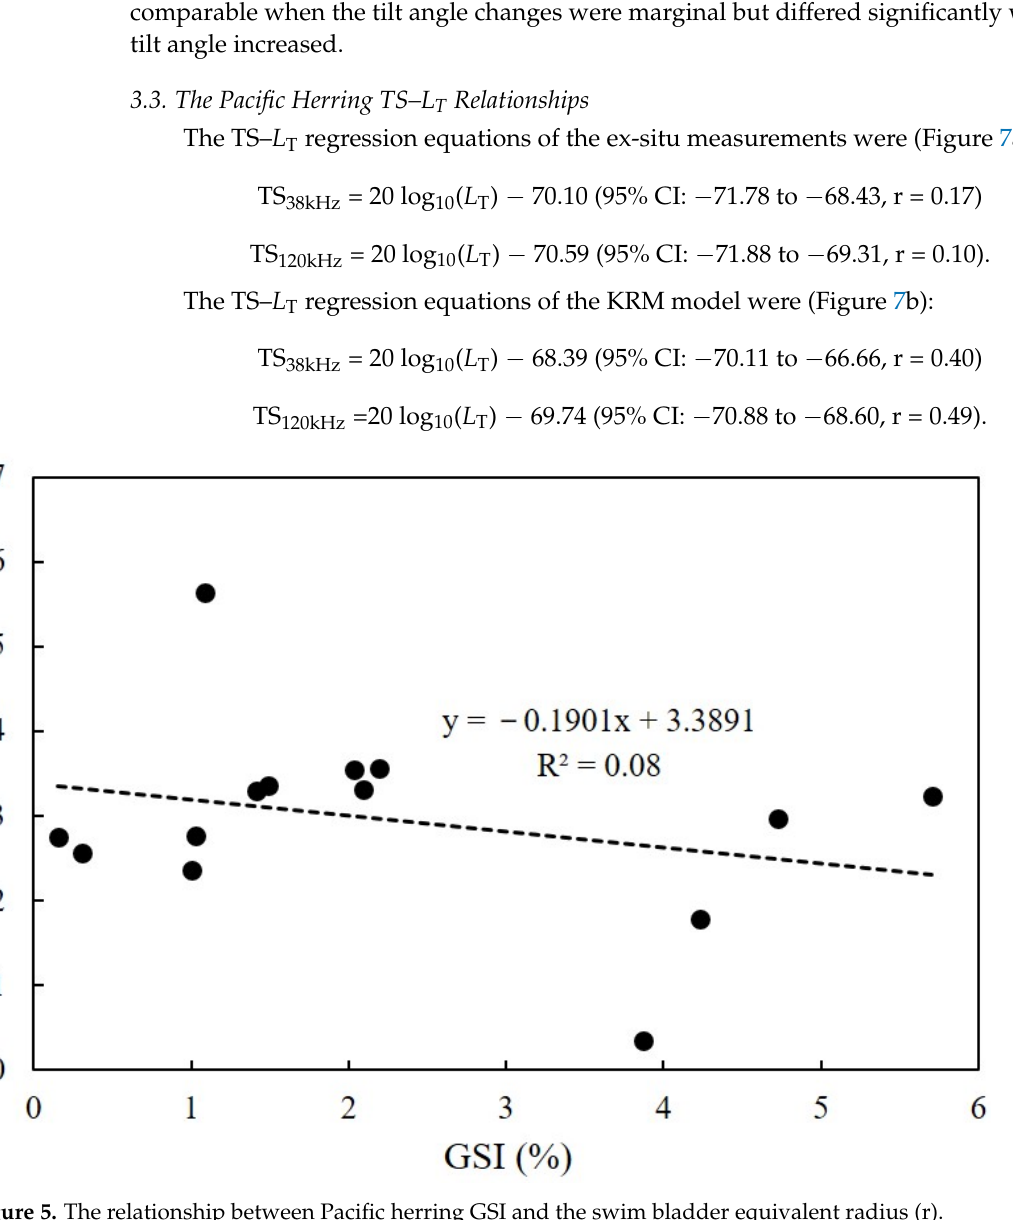
Figure 5. The relationship between Pacific herring GSI and the swim bladder equivalent radius (r).